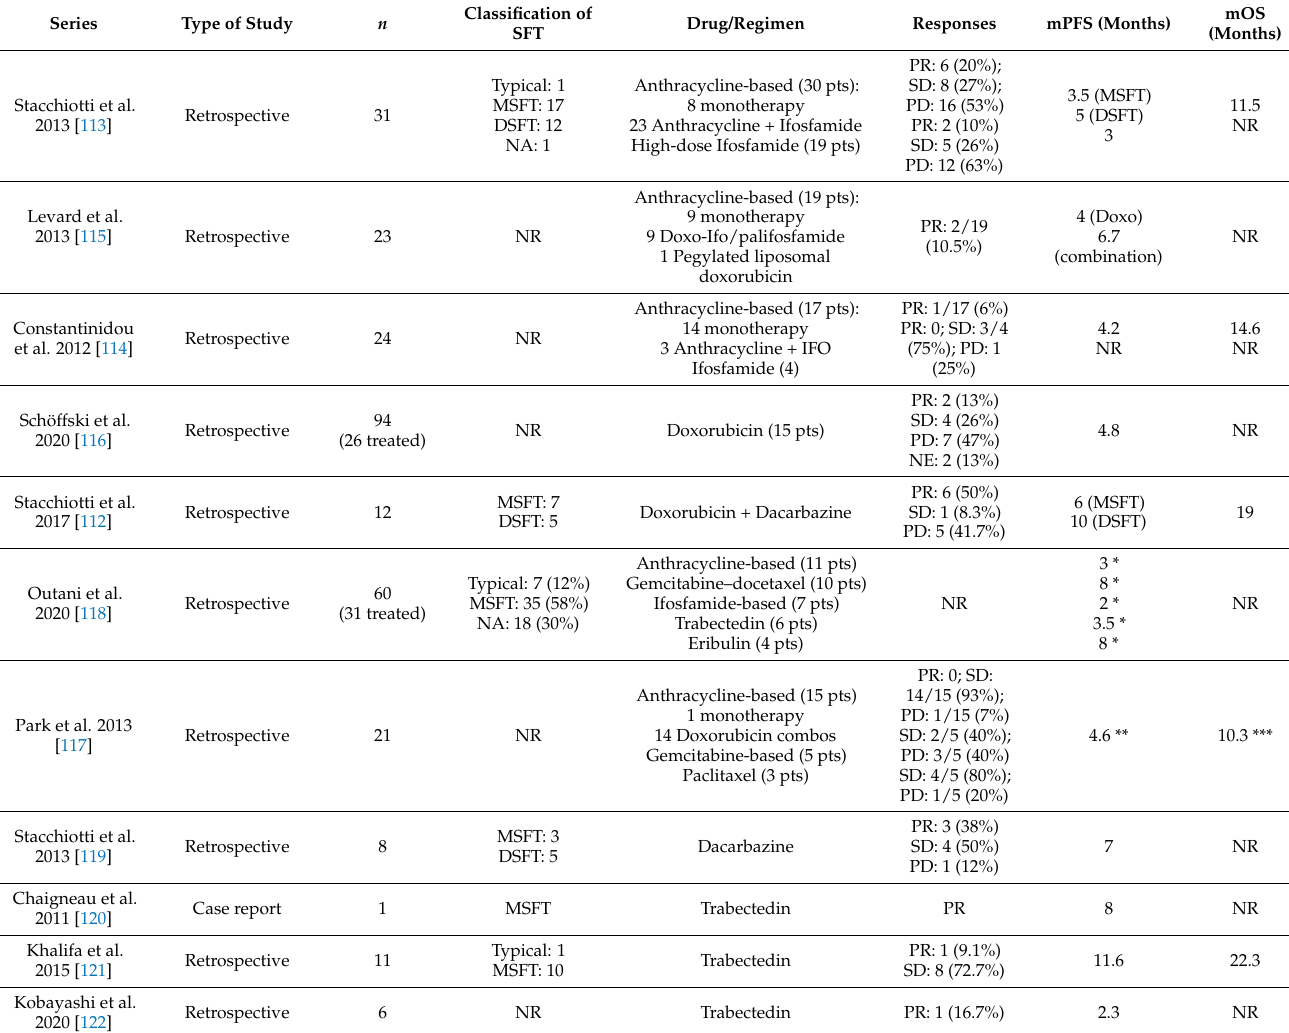
Table 3. Data on chemotherapy for advanced solitary fibrous